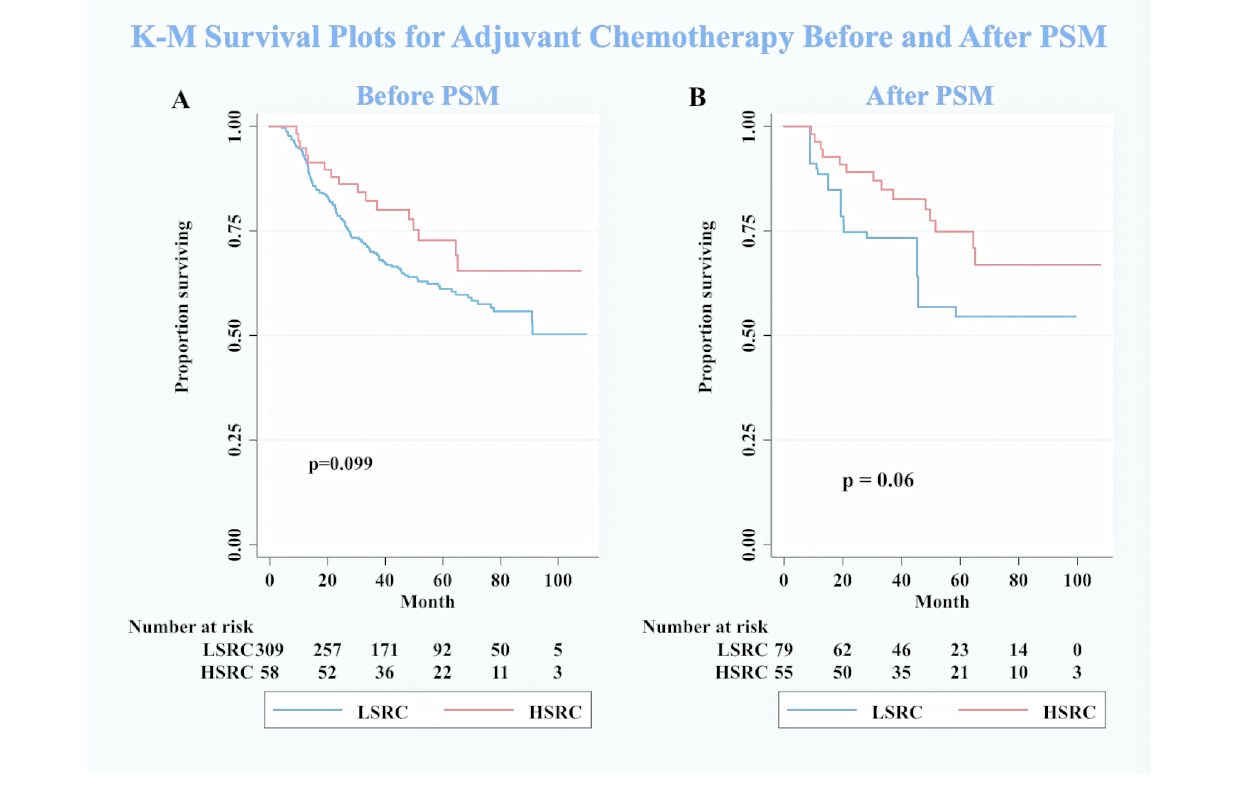
FIGURE 4 | Kaplan – Meier survival curves for patients with adjuvant chemotherapy between low-proportion signet ring cells LSRC and high-proportion signet ringcells. (A) Before PSM. (B) After